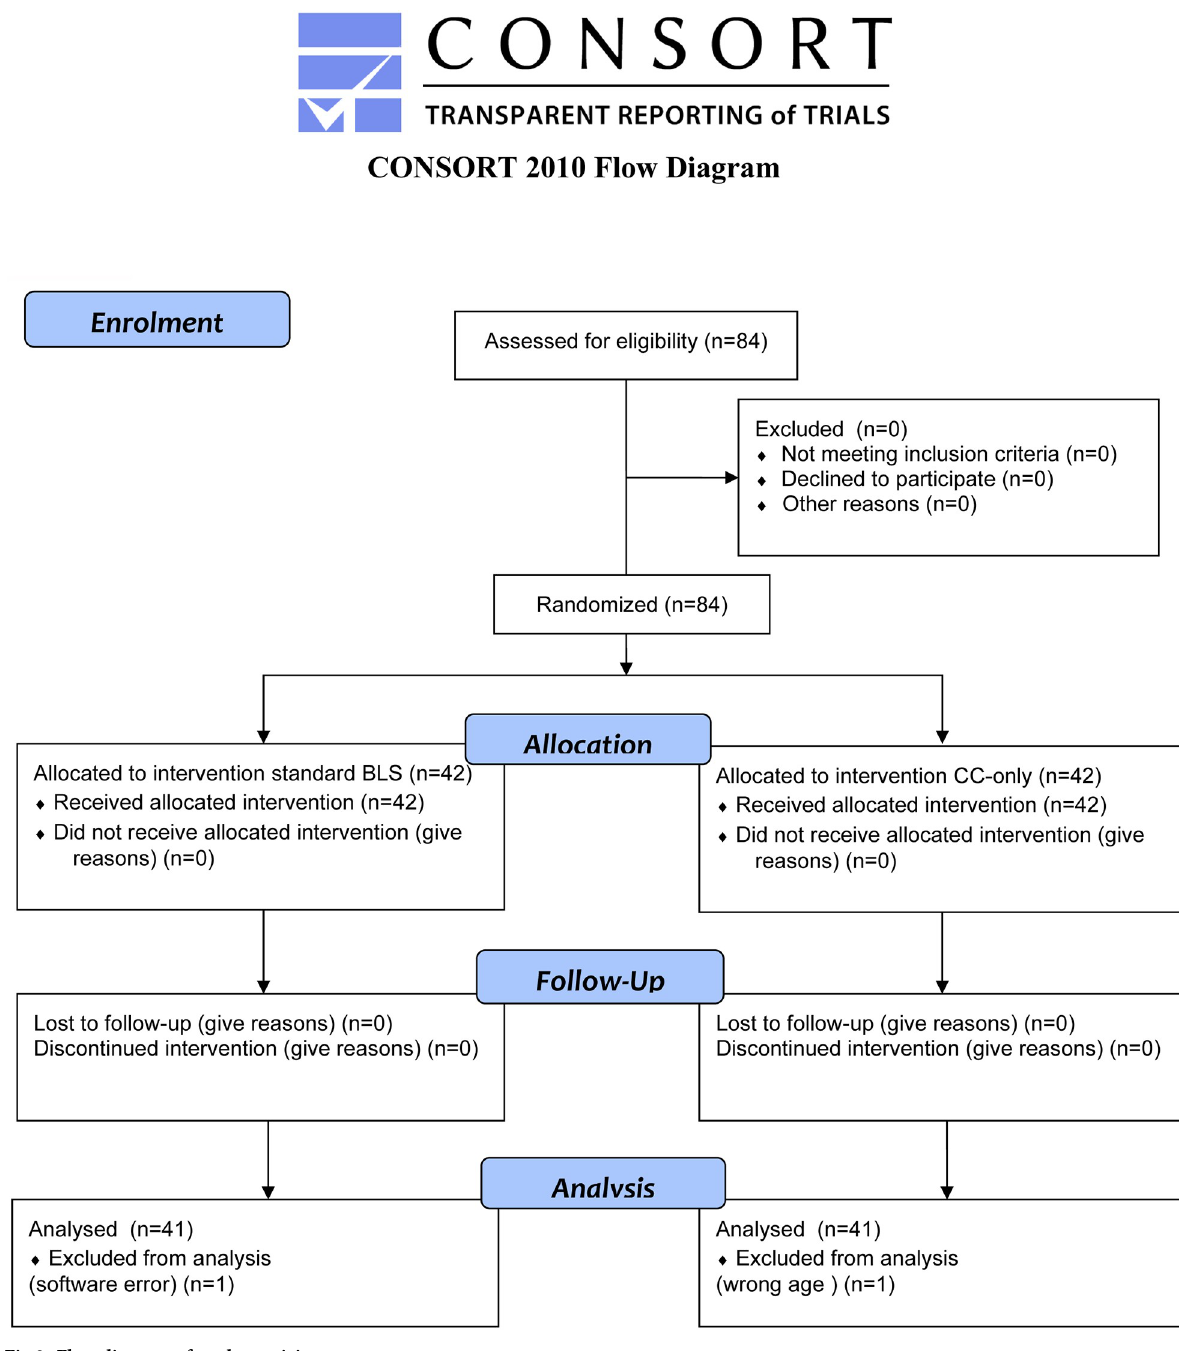
Fig 3. Flow diagram of study participants. (p < 0.001; 95% CI of difference: -171 to 63). Further details on quality of CCs in both groups are presented in Table 2. No participants in either group discontinued CPR before the end of the predefined 5min scenario duration. The time to exhaustion, the level of exhaustion at the end of the resuscitation efforts and the confidence level are provided in Table 2.